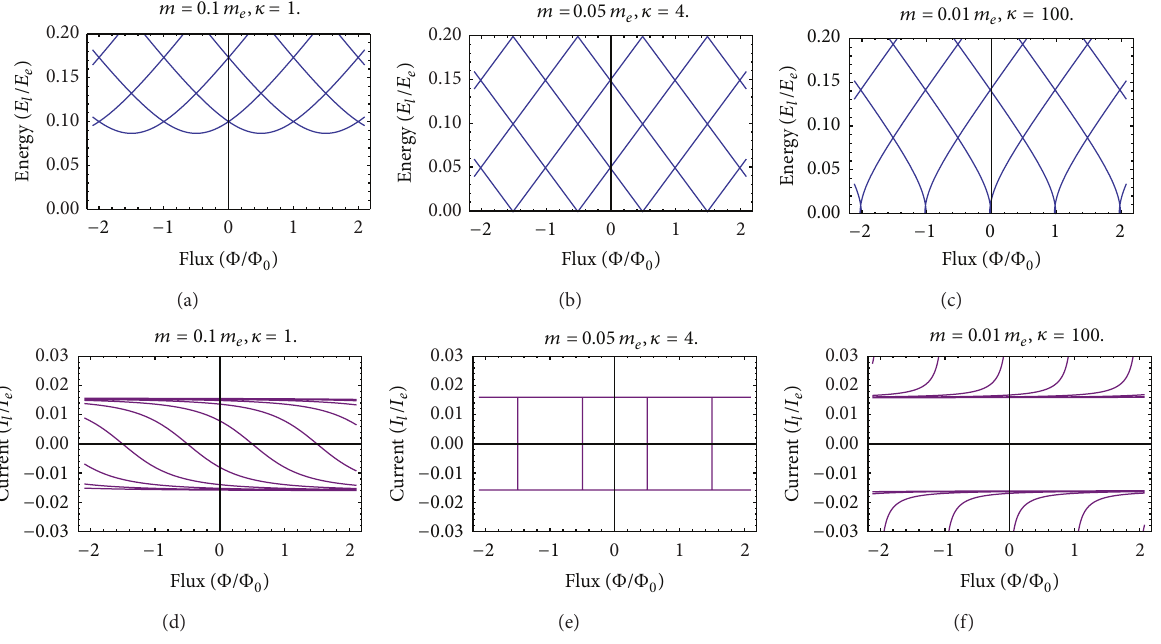
Figure 4: Nature of the energy and current for different values of 𝜅 . Here we use ( ℎ = 𝑐 = 𝑒 = 𝑚 𝑒 = 1 ) 𝑅 = 10𝑟 𝑒 and vary the mass. We have taken 𝑚 = 0.1𝑚 𝑒 (𝜅 = 1) , 𝑚 = 0.05𝑚 𝑒 (𝜅 = 4) , and 𝑚 = 0.01𝑚 𝑒 (𝜅 = 100) . 𝑚 = 0.05𝑚 𝑒 is the critical mass (12) at which energy becomes linear in flux and current attains a constant value 𝐼 sat (13). For 𝜅 > 4 , 𝐼 sat is the lower cutoff of the current.